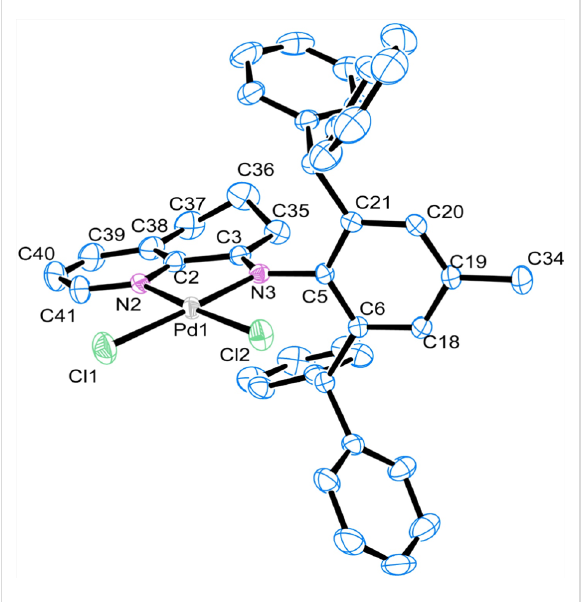
Figure 2: ORTEP drawing of Pd2 with thermal ellipsoids at 30% prob- ability level. Hydrogen atoms and the solvent CH 2 Cl 2 have been omitted for clarity.